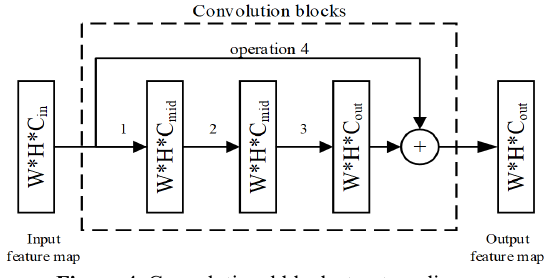
Figure 4 . Convolutional block structure diagram.